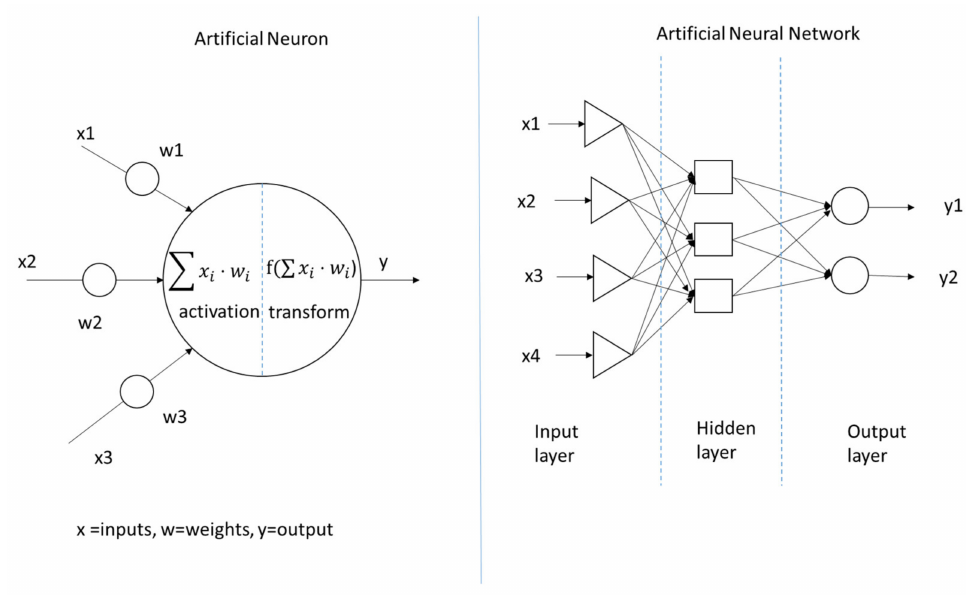
Figure 4. Artificial neuron with inputs Xi, output y, and activation function f ( left ) as well as artificial neural network with three layers (shallow network). The hidden and the output layers used specific case transfer functions ( right